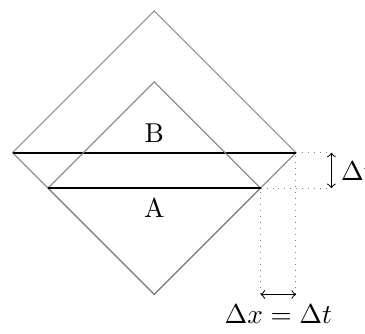
Figure 3 . Two regions A and B . Region B is larger than A by 2∆ t and is located ∆ t to the future of A